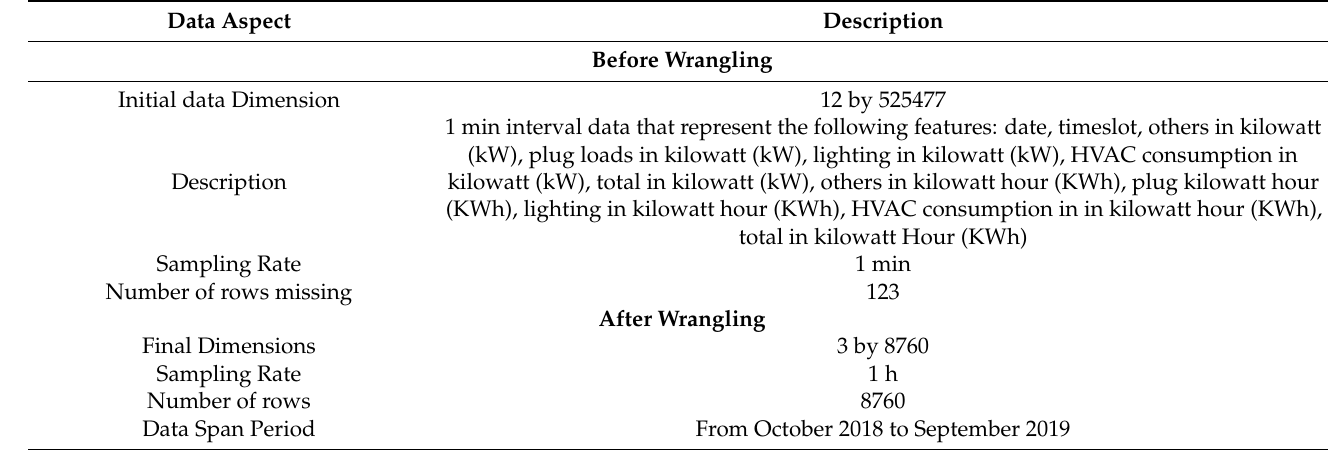
Table 1. HARC collected data—a